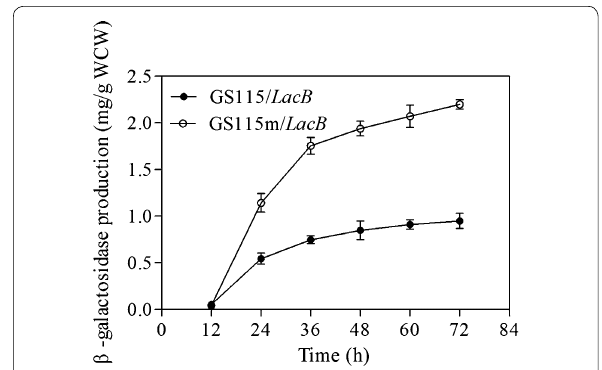
Fig. 1 β-Galactosidase production of the test strains cultured in YPR medium. WCW wet cell